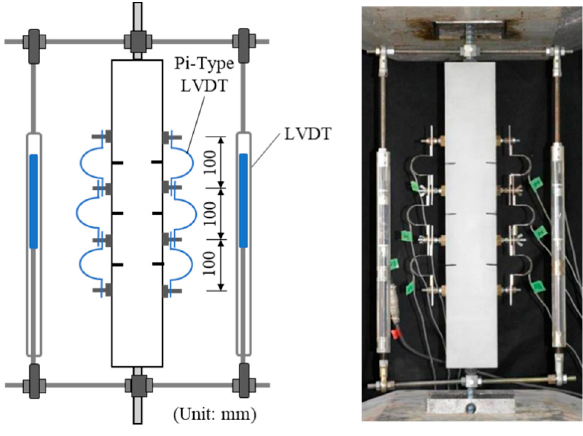
Figure 10. Setup of loading and measurement [24].